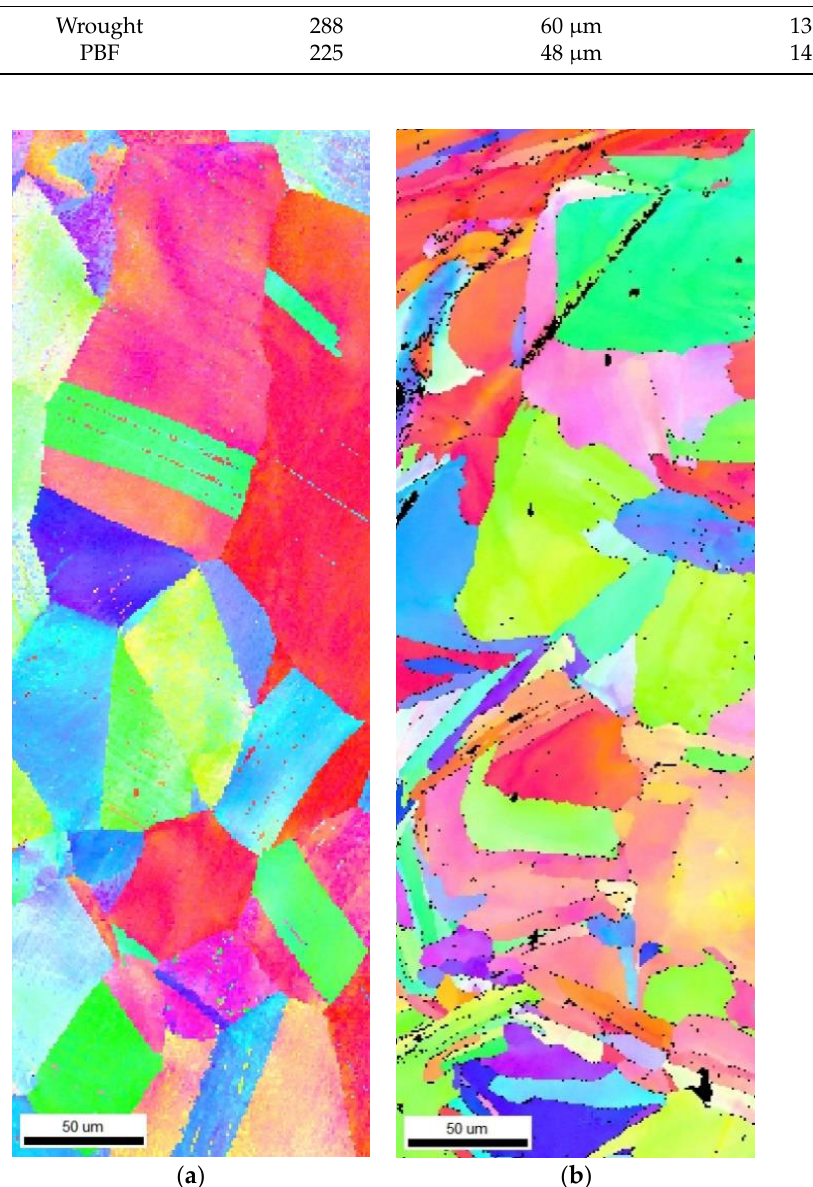
Figure 8. EBSD grain maps of ( a ) wrought SS316L and ( b ) SSPBF 316L. Scans were taken about 10 mm away from the PBF/wrought interface.